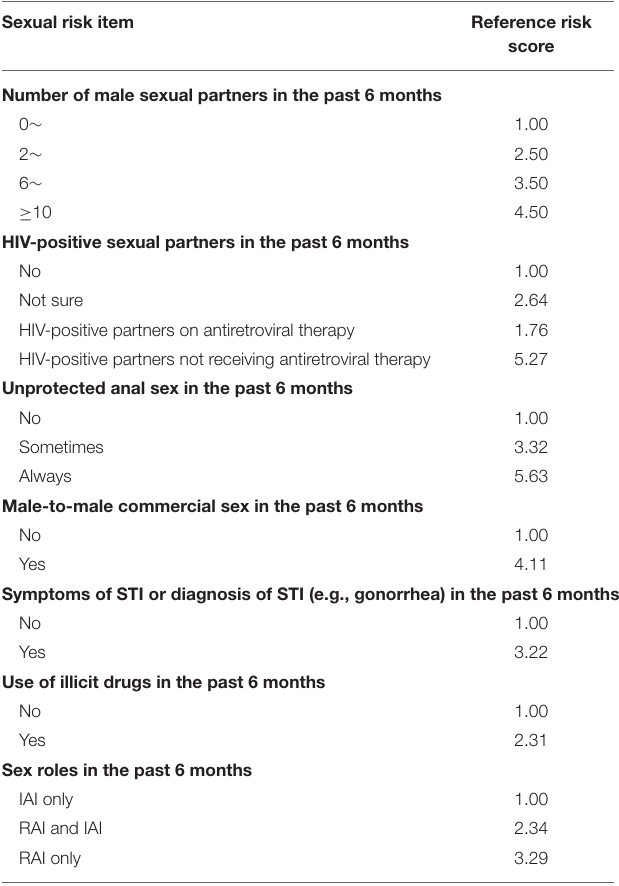
TABLE 1 | Revised MSM HIV infection risk assessment